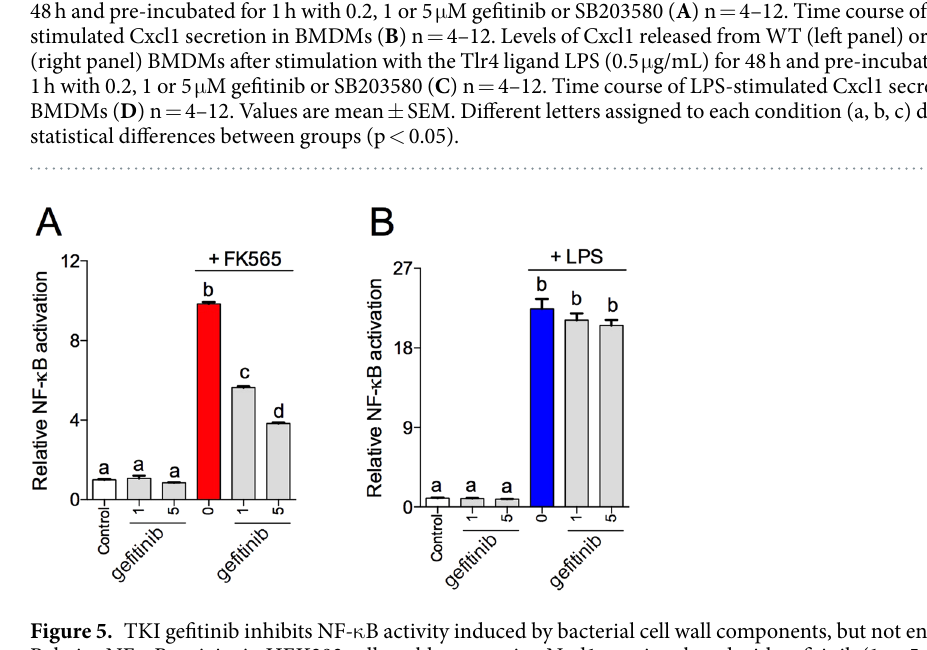
Figure 5. TKI gefitinib inhibits NF- κ B activity induced by bacterial cell wall components, but not endotoxin. Relative NF- κ B activity in HEK293 cells stably expressing Nod1, pre-incubated with gefitinib (1 or 5 μ M) and stimulated with FK565 (10 μ g/mL) ( A ), or in HEK293 cells stably expressing Tlr4, pre-incubated with gefitinib (1 or 5 μ M) and stimulated with LPS (0.5 μ g/mL) ( B ) n = 12. Values are mean ± SEM. Different letters assigned to each condition (a, b, c) denote statistical differences between groups (p <